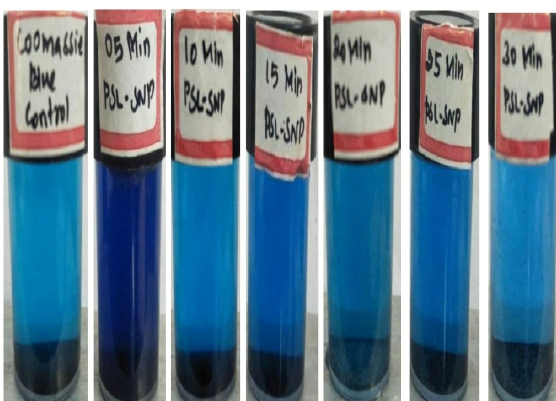
Fig. 9: Coomassie blue dye degradation of Pogostemon speciosus SNPs at various time intervals